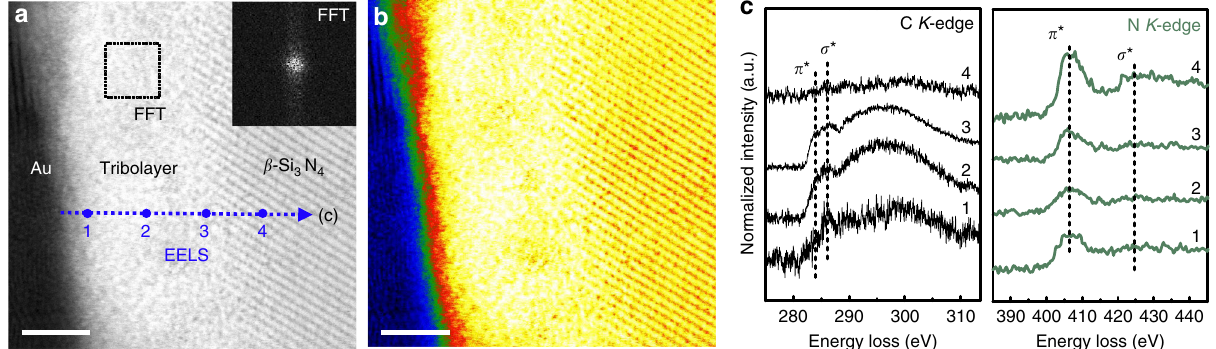
Fig. 4 Characterization of the contact area produced on bare Si 3 N 4 ball surface. The corresponding superlubricity test paired with a-C:H (ACF-1) surface is shown in Supplementary Fig. 6. a BF-STEM image showing a carbonaceous tribolayer of ~ 5 nm thickness in situ generated on the ceramic ball surface. (Inset) FFT image derived from the square dashed box demonstrating the mainly amorphous nature of the formed tribolayer. b The corresponding false- color displayed BF-STEM image for a . Scale bars in a and b , 2 nm. c Evolution of C- K and N- K EELS core-edge spectra recorded across the tribolayer as marked in